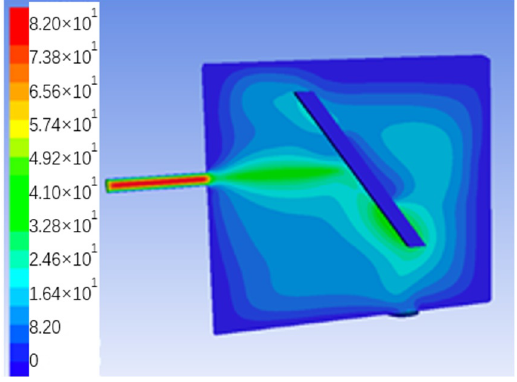
Figure 14. Velocity distribution.